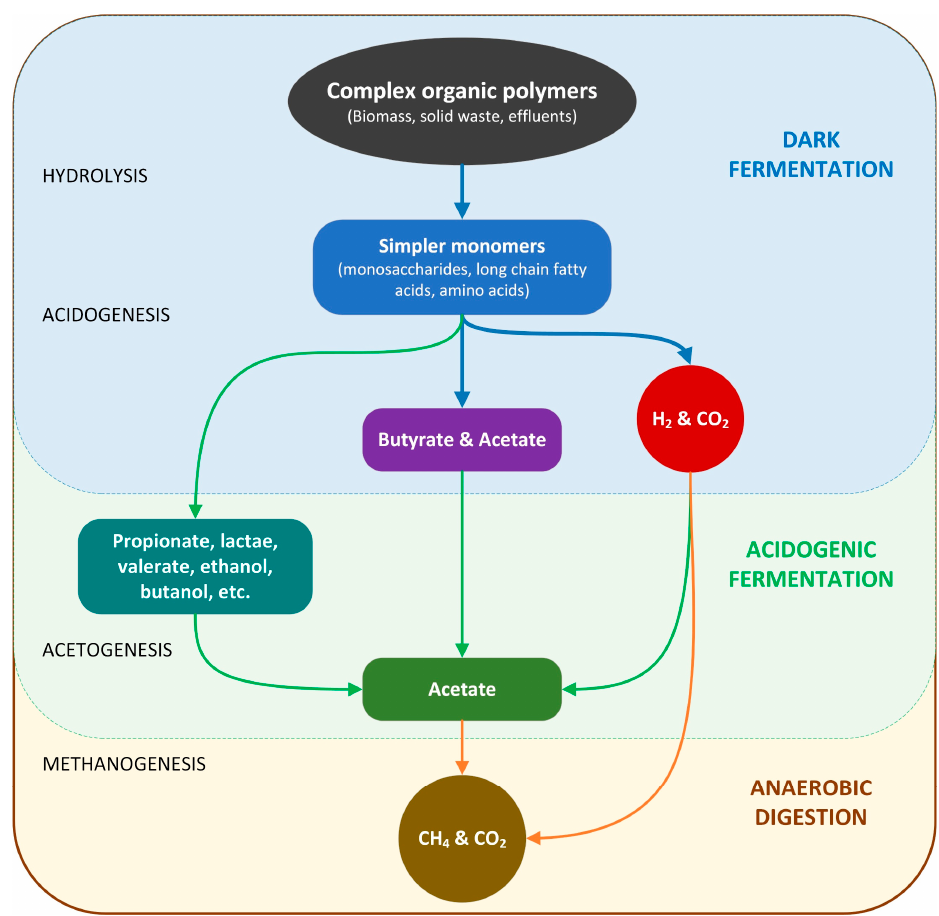
Figure 3. The link between DF process and AD process.